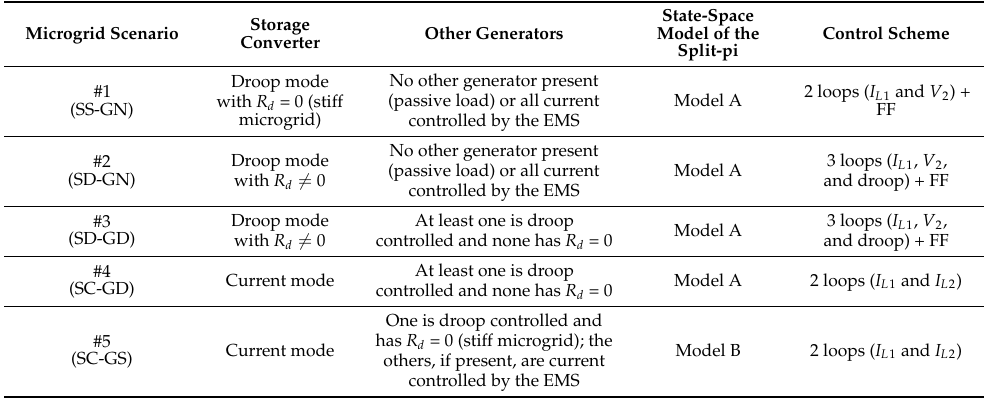
Table 1. Possible combinations of microgrid scenarios, converter models, and control schemes for the Split-pi.